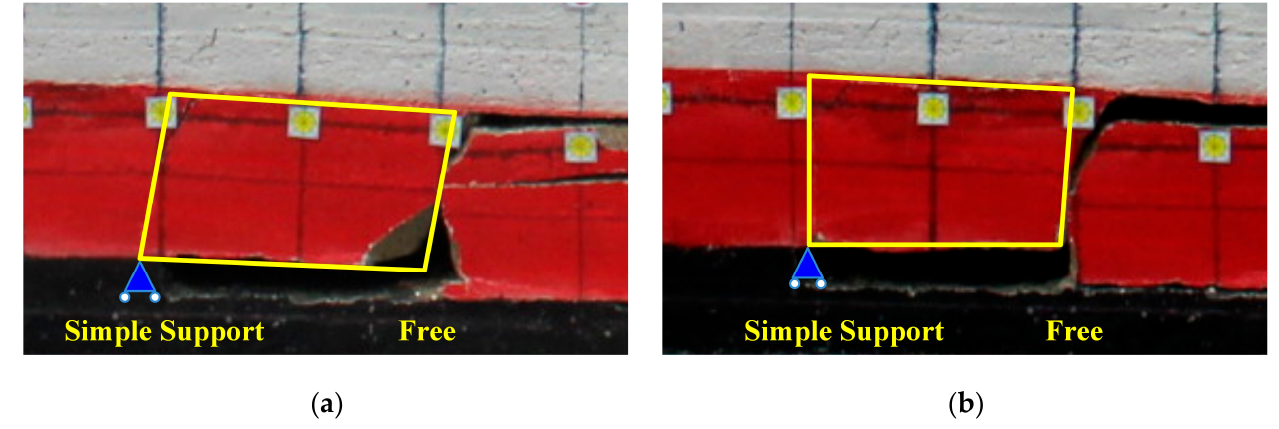
Figure 3. Cut falling body “Simple support—Free” structure: ( a , b ) are ,respectively, the forms of roof cut falling body when the model is excavated to different distances.